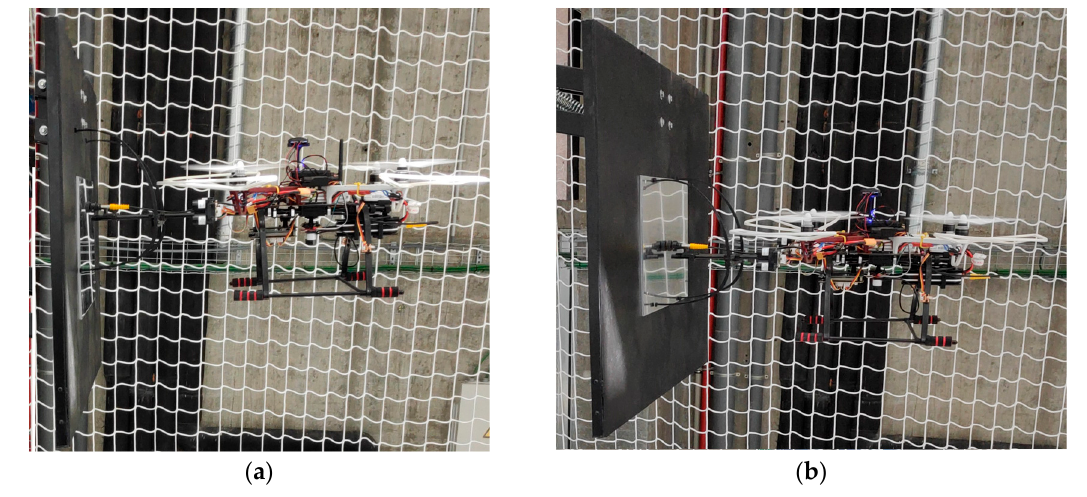
Figure 15. Image of the UAV during the contact. ( a ) Side view. ( b ) Oblique view.